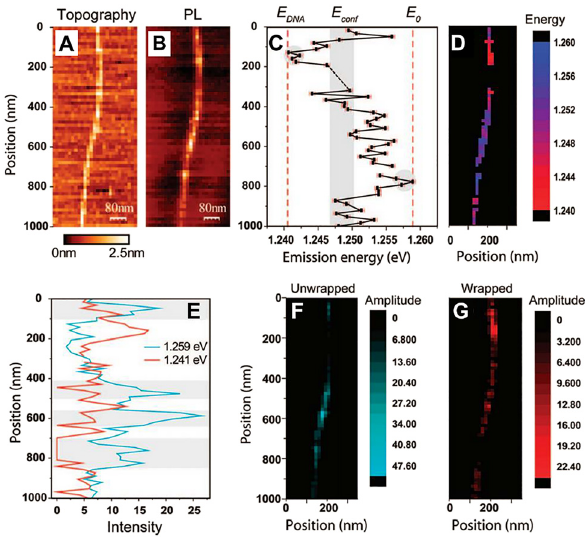
Figure 10: AFM topography (A) and simultaneously measured near- field PL image (B) of a DNA-wrapped carbon nanotube on the mica substrate. (C, D) Position-dependent peak emission energies derived from the TEPL spectra along the 1D sample. To derive the peak values at each position, the measured spectra were fitted with a Lorentzian line function. (E) Position-dependent PL intensities for emission peaks of 1.241 eV (DNA-wrapped segments) and 1.259 eV (DNA-unwrapped segments). TEPL intensities with respect to the position of a carbon nanotube for the peaks of 1.259 eV (F) and 1.241 eV (G) [128]. Reprinted with permission from [128]. Copyright (2008) American Chemical